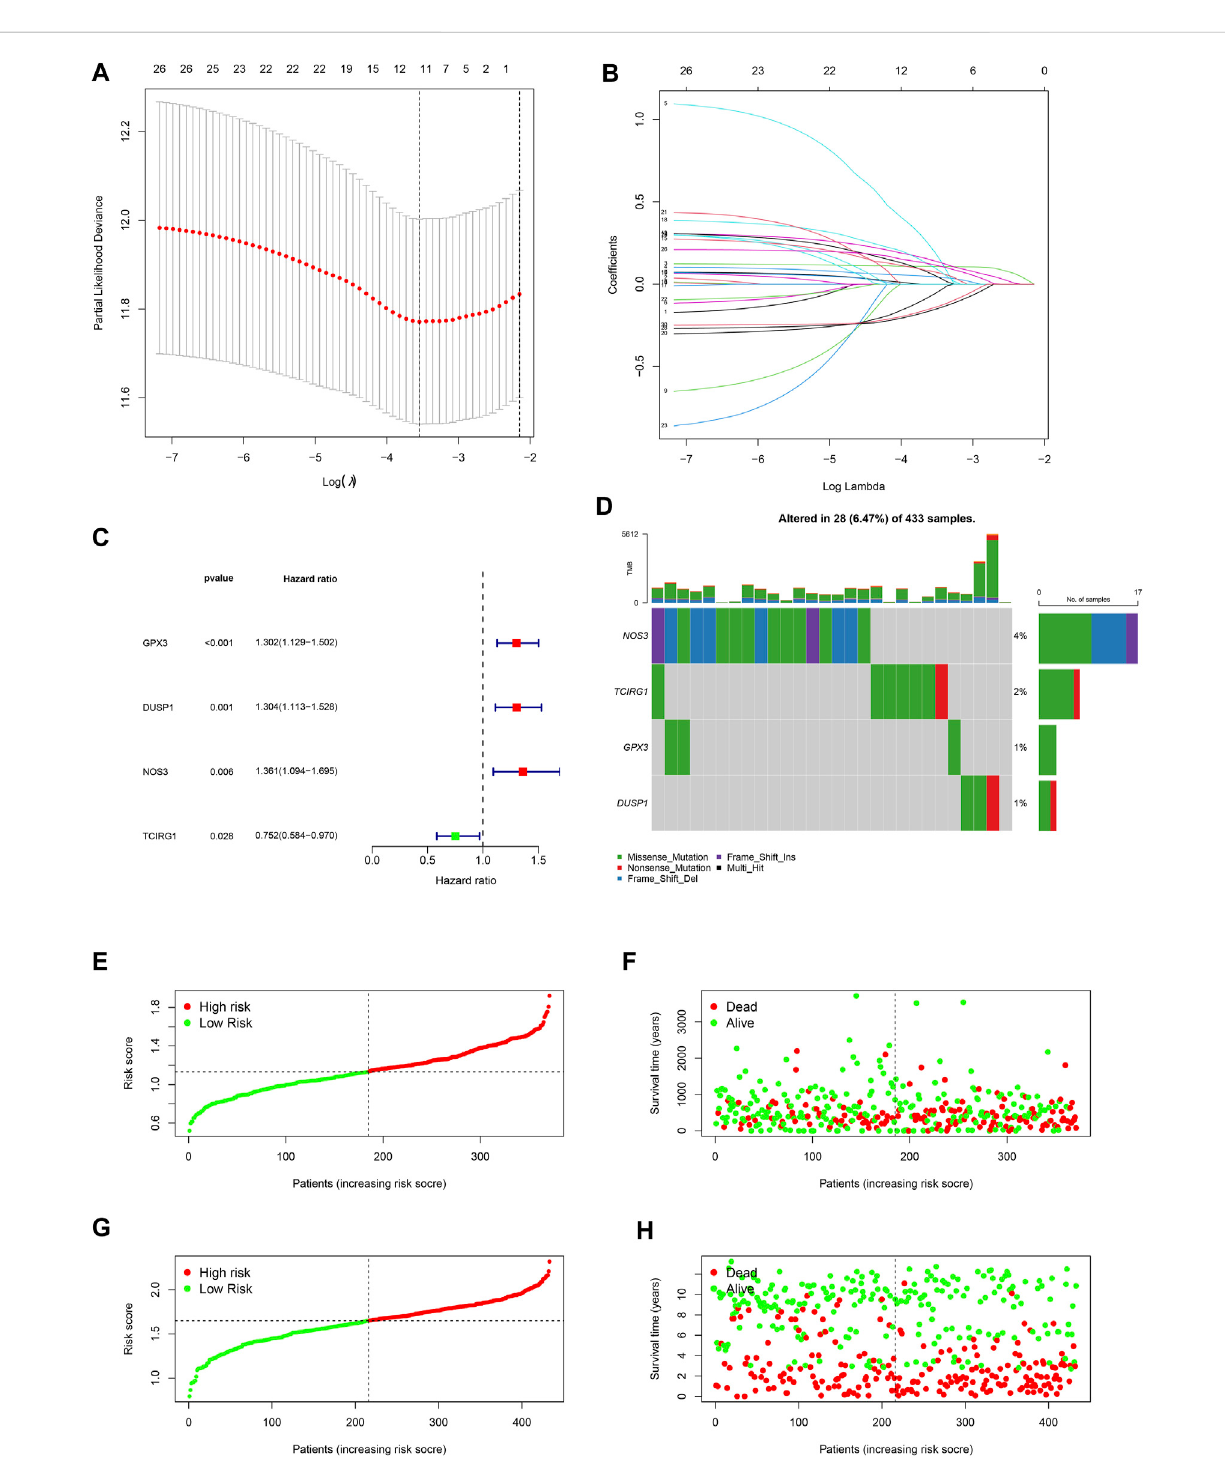
FIGURE 4 Development of a ROS-related signature in GC. (A) A univariable Cox regression analysis of genes constructing the signature. (B) A waterfall of mutation pro fi le of genes constructing the ROS-related signature. (C) LASSO regression of prognostic genes of cluster 1 and 2. (D) Cross-validation for tuning parameter selection. (E) Risk score of GC in TCGA-STAD dataset. (F) Correlation of survival status with risk score in TCGA-STAD dataset. (G) Risk score of GC in GSE84437 dataset. (H) Correlation of survival status in GSE84437